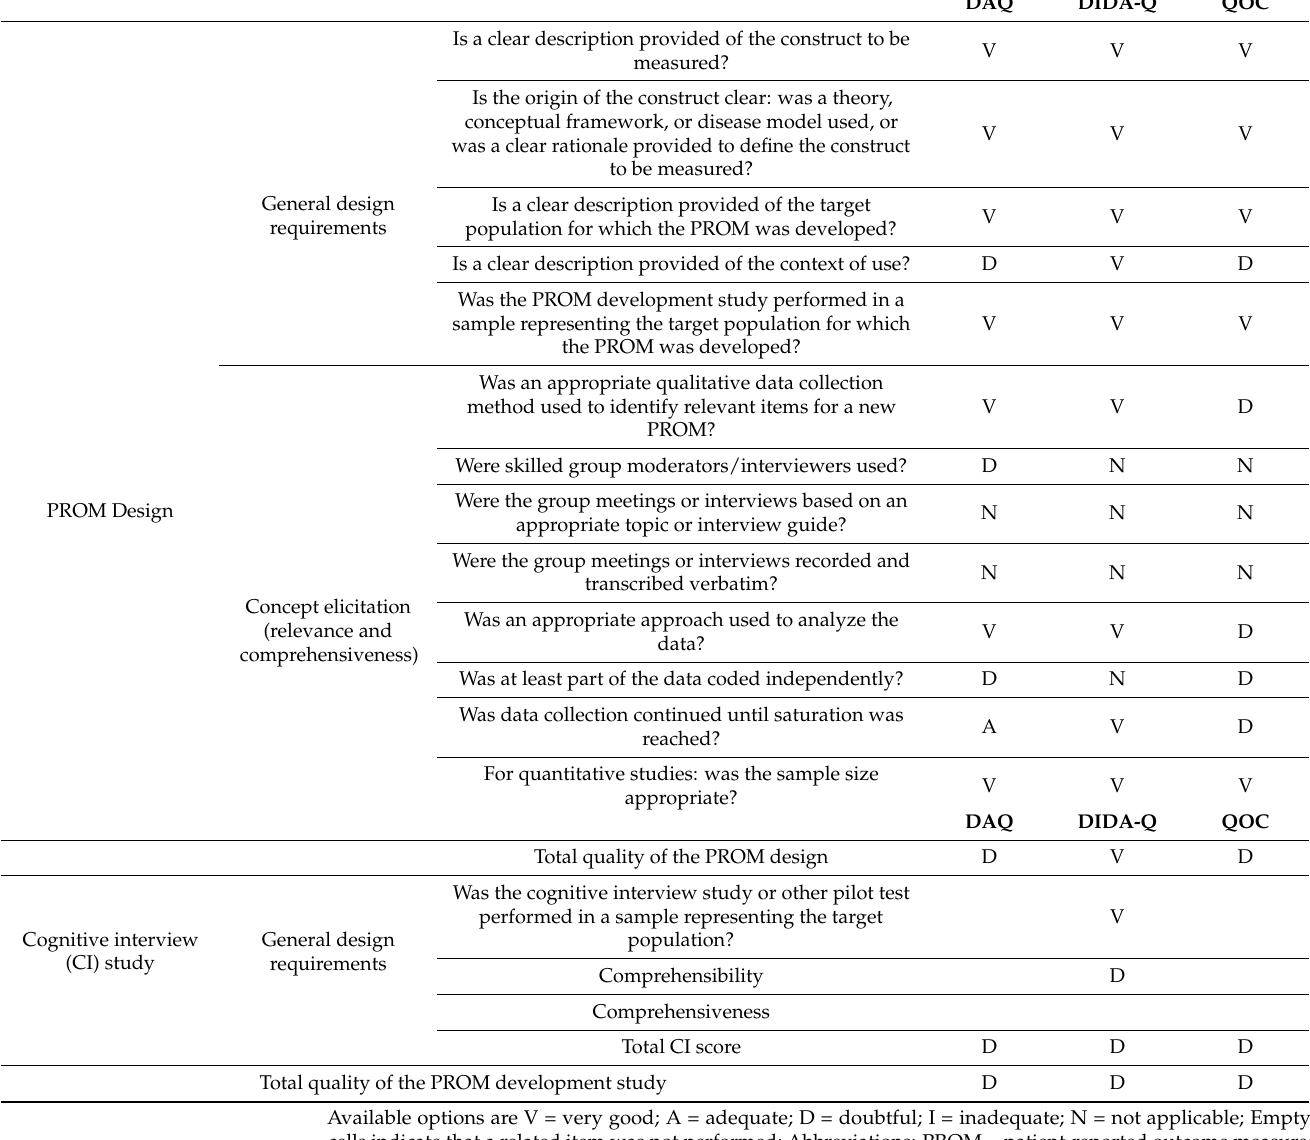
Table 3. Quality of PROM